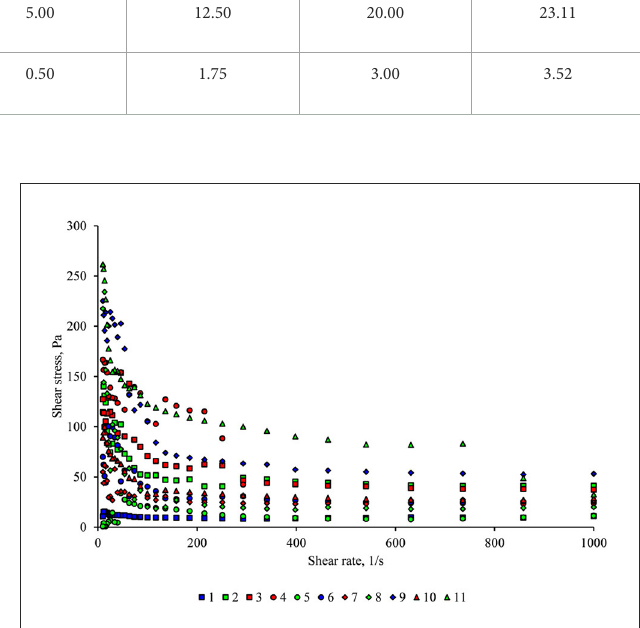
FIGURE1 The flow curves (shear stress vs. shear rate) of egg white-based beverages with different mixed berries and bovine collagen peptide concentrations (samples are coded by test